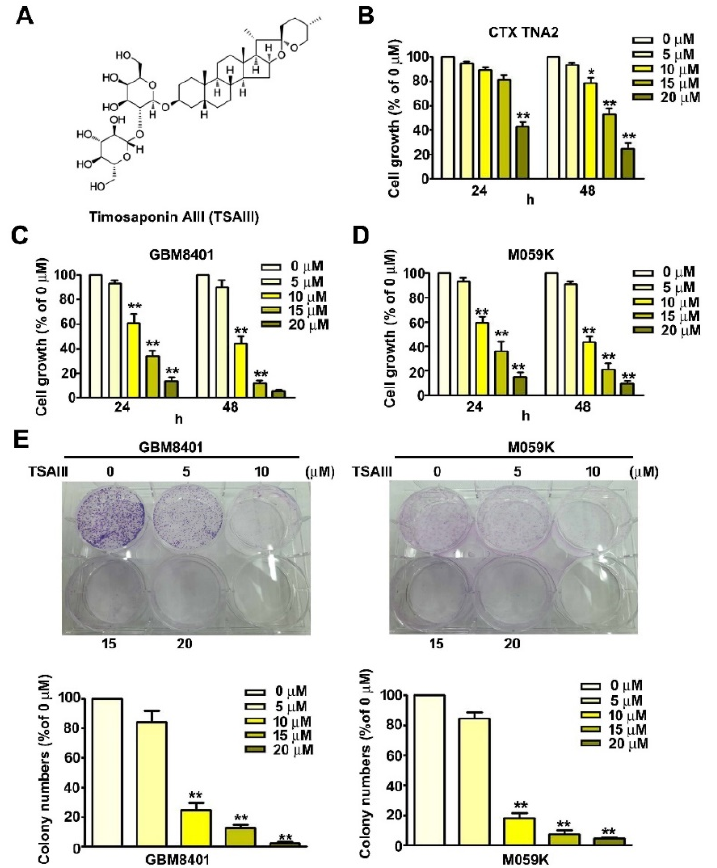
Figure 1. TSAIII decreased viability and inhibited the proliferation of human glioma cells. ( A ) TSAIII structure; ( B ) normal astrocyte (CTX TNA2) cells and ( C , D ) human glioma cells (GBM8401 and M059K) were treated with various concentrations of TSAIII for 24 or 48 h. Cell growth was determined by MTT assay. ( E ) Proliferation rates were determined using the colony-forming assay. Each experiment was repeated three times, and data are presented as the mean ± SE. * p < 0.05; ** p < 0.01 vs. untreated cells.